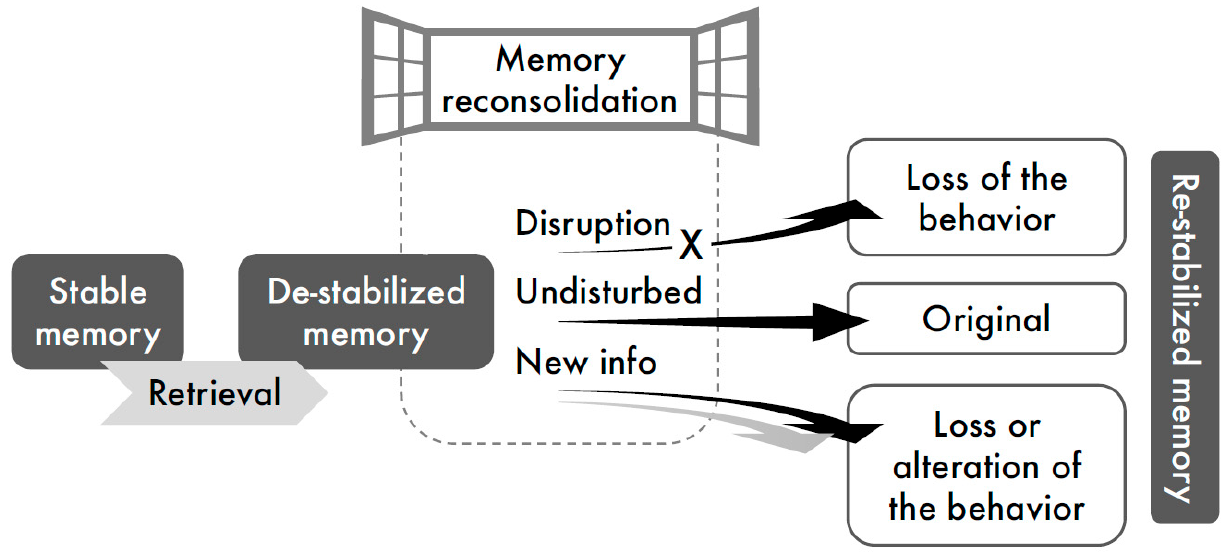
Figure 1. Schematic illustration of interference with memory reconsolidation. According to the reconsolidation hypothesis, stable memories de-stabilize upon retrieval and undergo a time-dependent processing to be re-stabilized. Treatments delivered shortly after memory retrieval, during the “reconsolidation window”, can disrupt reconsolidation, leading to the loss of the memory-evoked behavior (amnestic pharmacological agents), or can incorporate new information into the original memory, consequently altering the target behavior (behavioral manipulations).